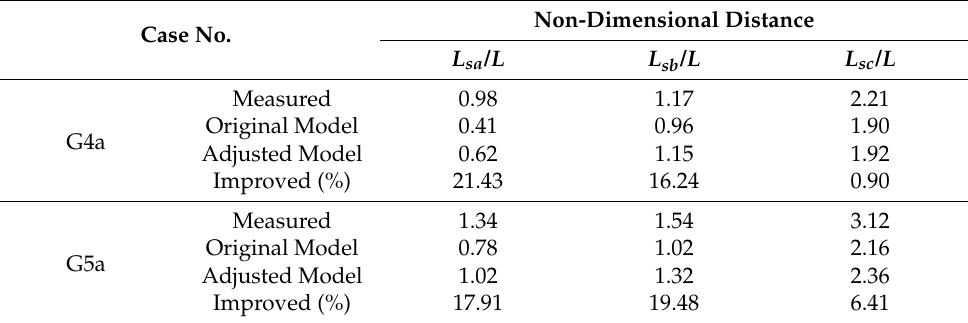
Figure 16. Sketch of a local scour hole around a spur dike. Modified from a study by Copeland [22]. Table 3. Comparison of the measured and simulated non-dimensional distance of the scour hole around the spur